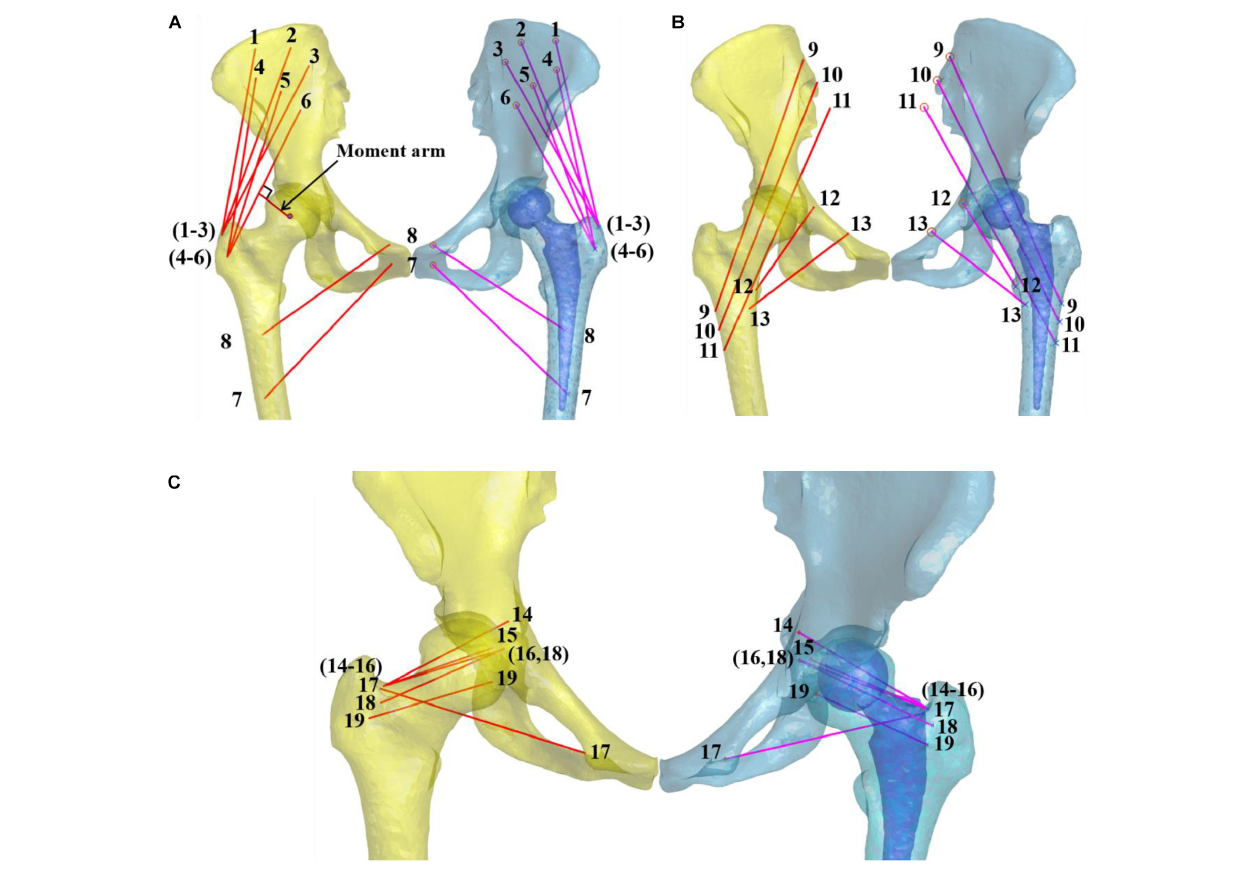
FIGURE 2 | The pelvic and femoral bone models with the skeletal hip muscle lines of action. (A) The abductor and adductor include gluteus medius [anterior bundle (1, GMDA), median bundle (2, GMDM), posterior bundle (3, GMDP)], gluteus minimus [anterior bundle (4, GMIA), median bundle (5, GMIM), posterior bundle (6, GMIP)], adductor brevis (7, AB), and pectineus (8, PT). (B) The extensor muscle group include the gluteus maximus [anterior bundles (9, GMXA), median bundles (10, GMXM), posterior bundles (11, GMXP)]. The flexor muscle group includes the iliacus (12) and psoas (13). (C) The external rotation muscle group includes the gemellus superior (14, GS), gemellus inferior (15, GI), obturator internus (16, OI), obturator externus (17, OE), piriformis (18, PF), and quadratus femoris (19, QF). The muscle moment arm was defined as the femoral head’s rotation center perpendicular distance to each muscle simulation line. The moment arm of GMIP was shown at the